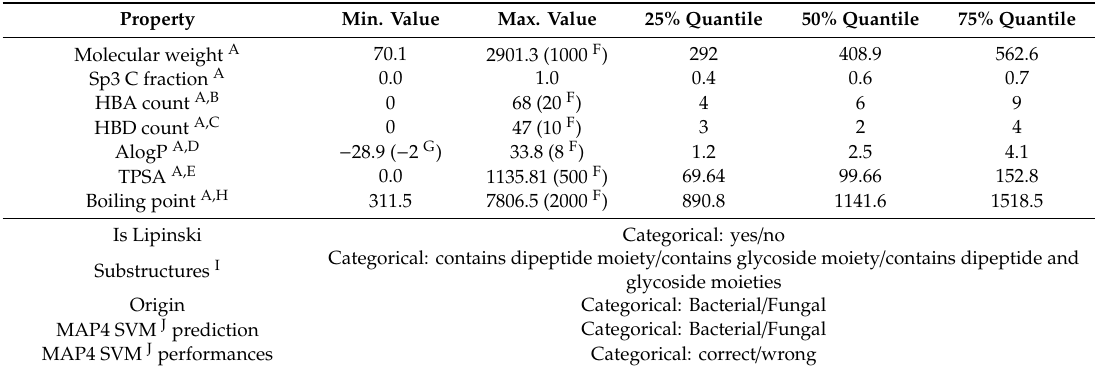
Table 1. Calculated properties of NPAtlas molecules available as TMAP color-codes.